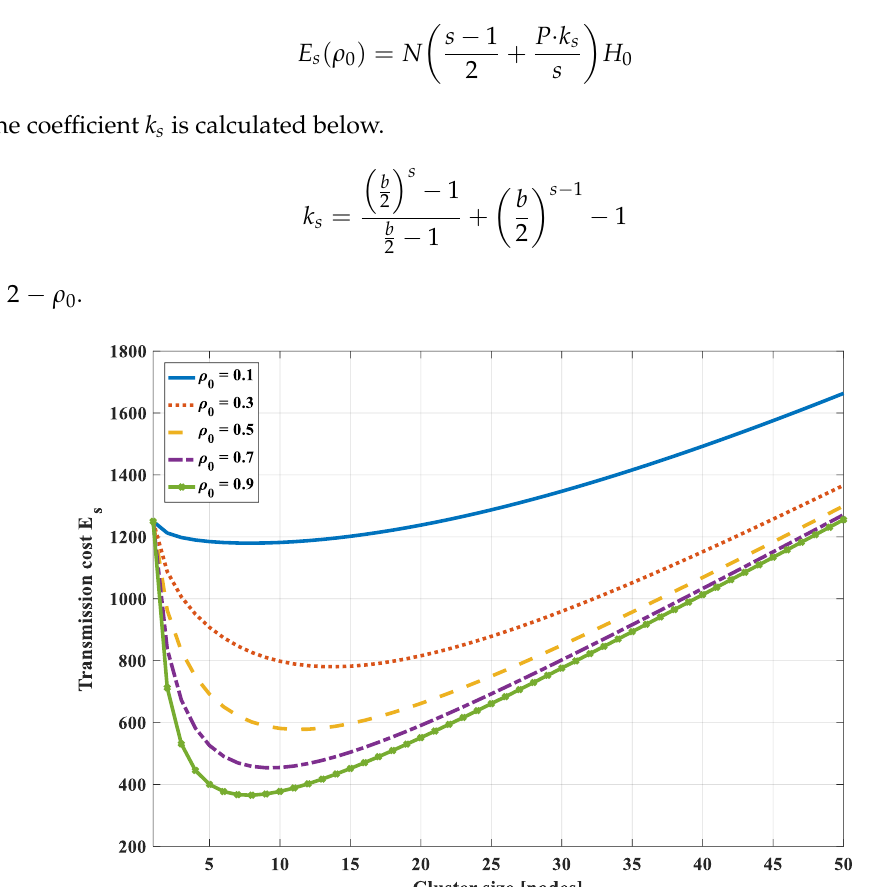
Figure 11. Total bit-hop cost E s , respectively, to cluster size with different values of an entropy correlation coefficient in the case of 1-D with compression at a cluster head only.